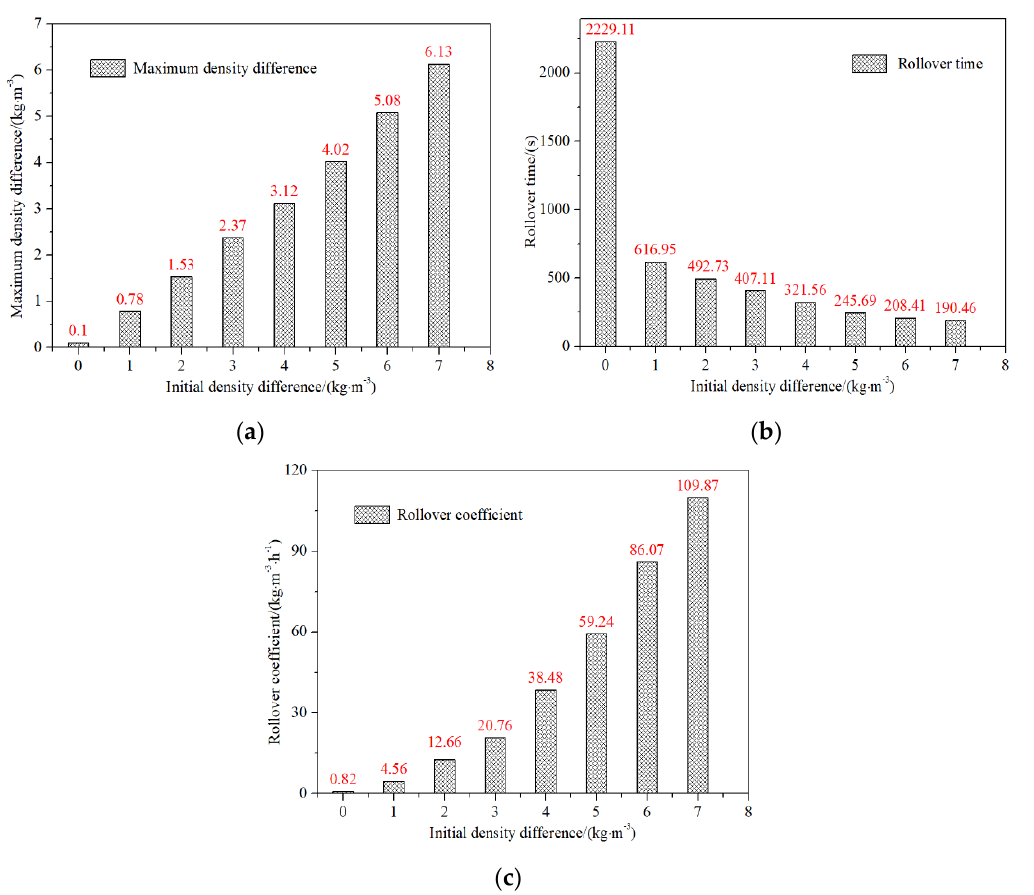
Figure 6. Relation of maximum density difference, rollover time, and rollover coefficient of the storage tank with initial density difference. ( a ) Maximum density difference; ( b ) rollover time; ( c ) rollover coefficient. This figure is adapted from [74].